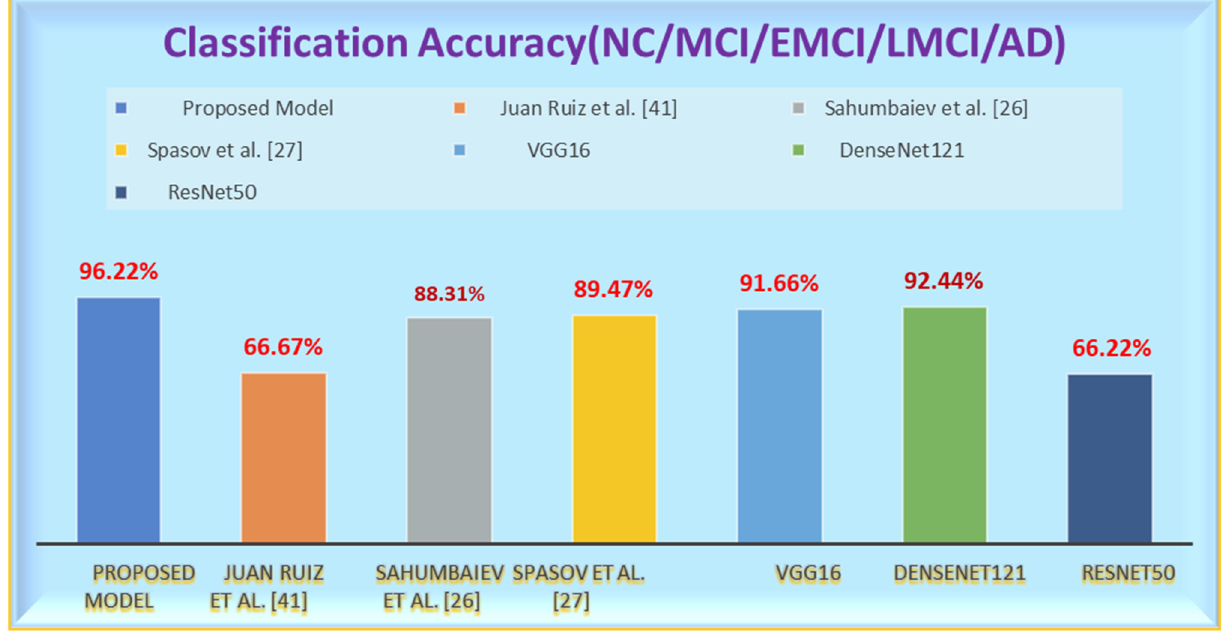
Figure 7. Assessment of the devised architecture with the existing frameworks. Our model shows better performance results than existing architectures [61,62].